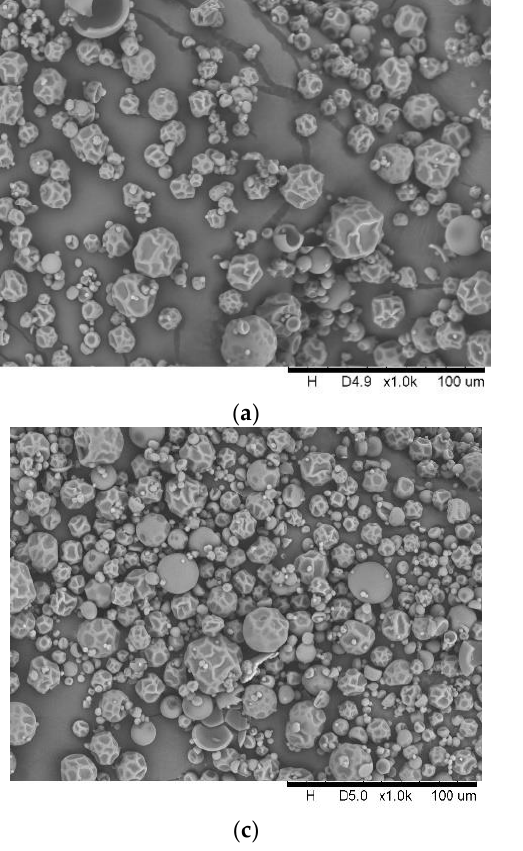
Figure 3. SEM image of powders ( a ) LB_powder; ( b ) LF_powder. ( c ) LP_powder; ( d ) SF_powder; (SF — spontaneous fermentation, LB — Levilactobacillus brevis , LF — Limosilactobacillus fermentum , LP — Lactiplantibacillus plantarum ).